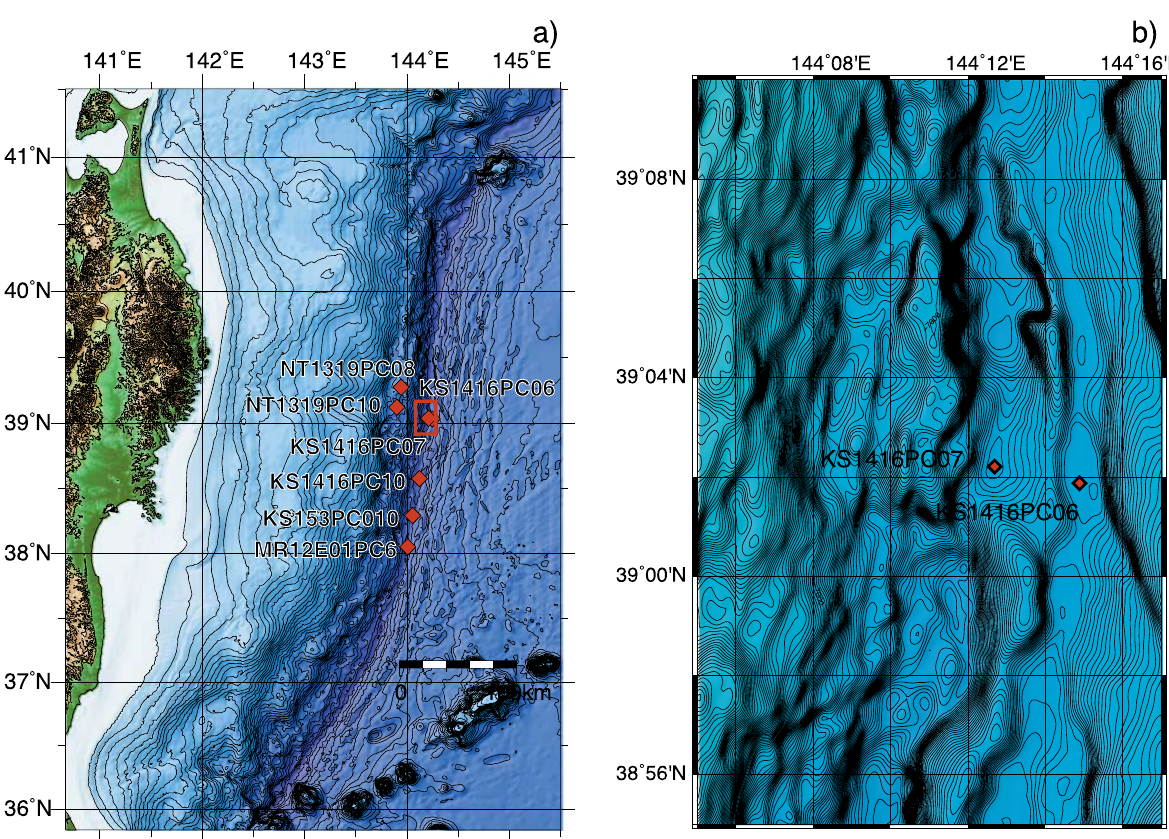
Fig. 1 a Legend map of the study area: Red filled diamonds show the location of piston cores in this study and the core locations from earlier studies (Kanamatsu et al. 2017, 2023; Usami et al. 2018); the red box shows the area of b . b Detailed bathymetric map and piston core locations of cores KS1416PC06 and